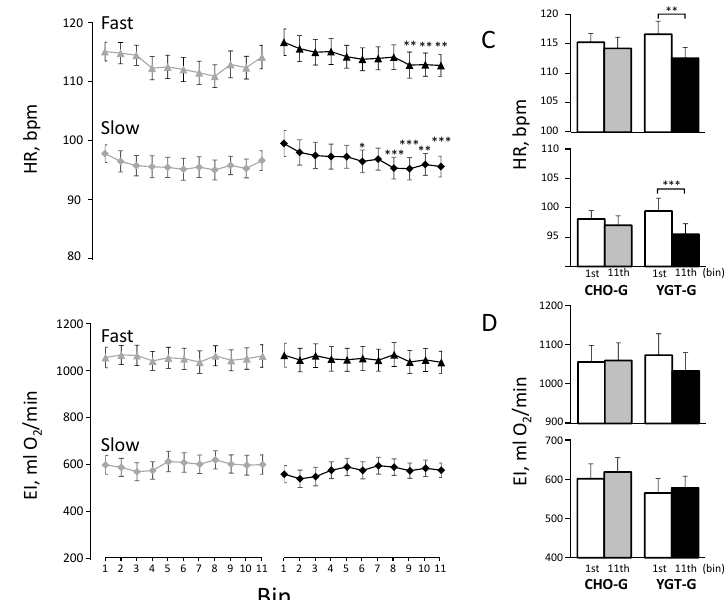
Figure 4. The profiles of heart rate (HR) ( A ) and exercise intensity (EI) ( B ) for the last set of IWT throughout the intervention in both groups. The comparison of HR fast and HR slow between the 1st and 11th bins are presented in the upper and lower panels, respectively ( C ). Similarly, the comparison of EI fast and EI slow between the 1st and 11th bins are presented in the upper and lower panels, respectively ( D ). *, **, and *** indicate significant differences vs. the 1st bin at the levels of p < 0.05, p < 0.01, and p < 0.001, respectively. Other symbols and abbreviation are the same as in Figure 3.